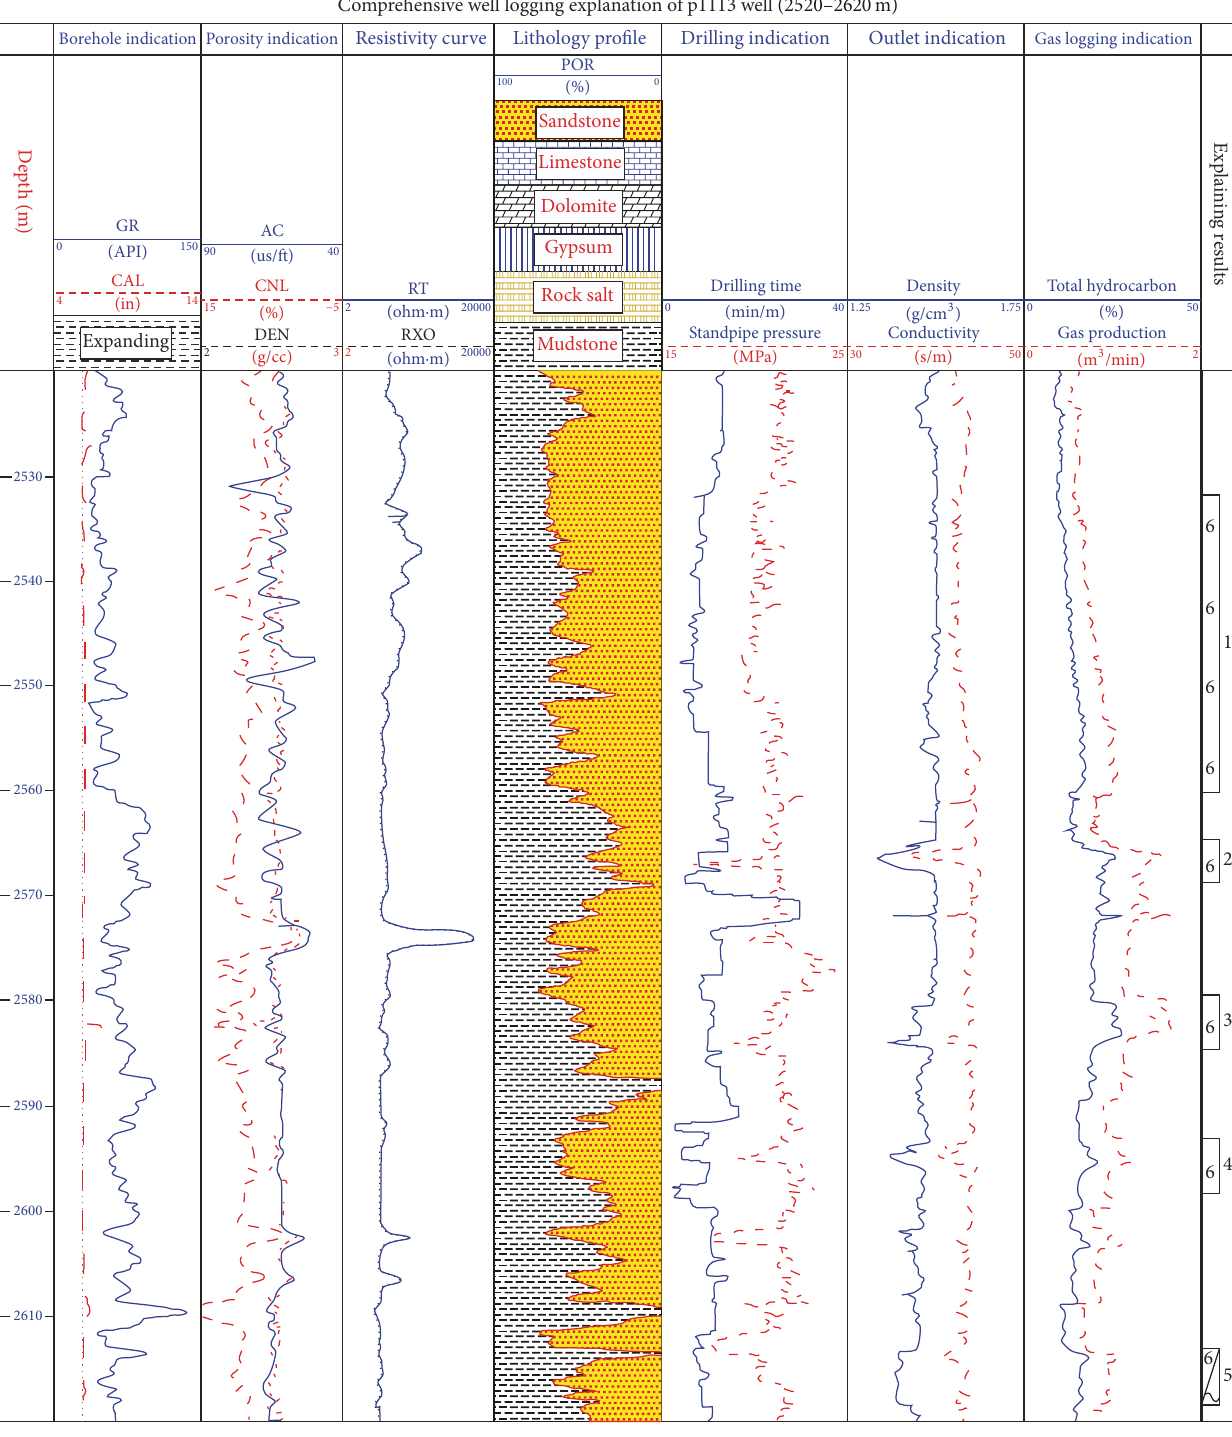
Figure 6: Comprehensive well logging of PL113 well (2520–2620